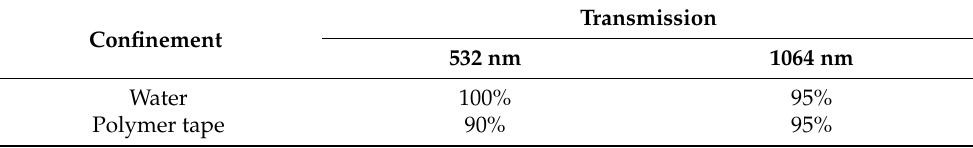
Table 2. Optical transmission of water and polymer tape at 532 and 1064